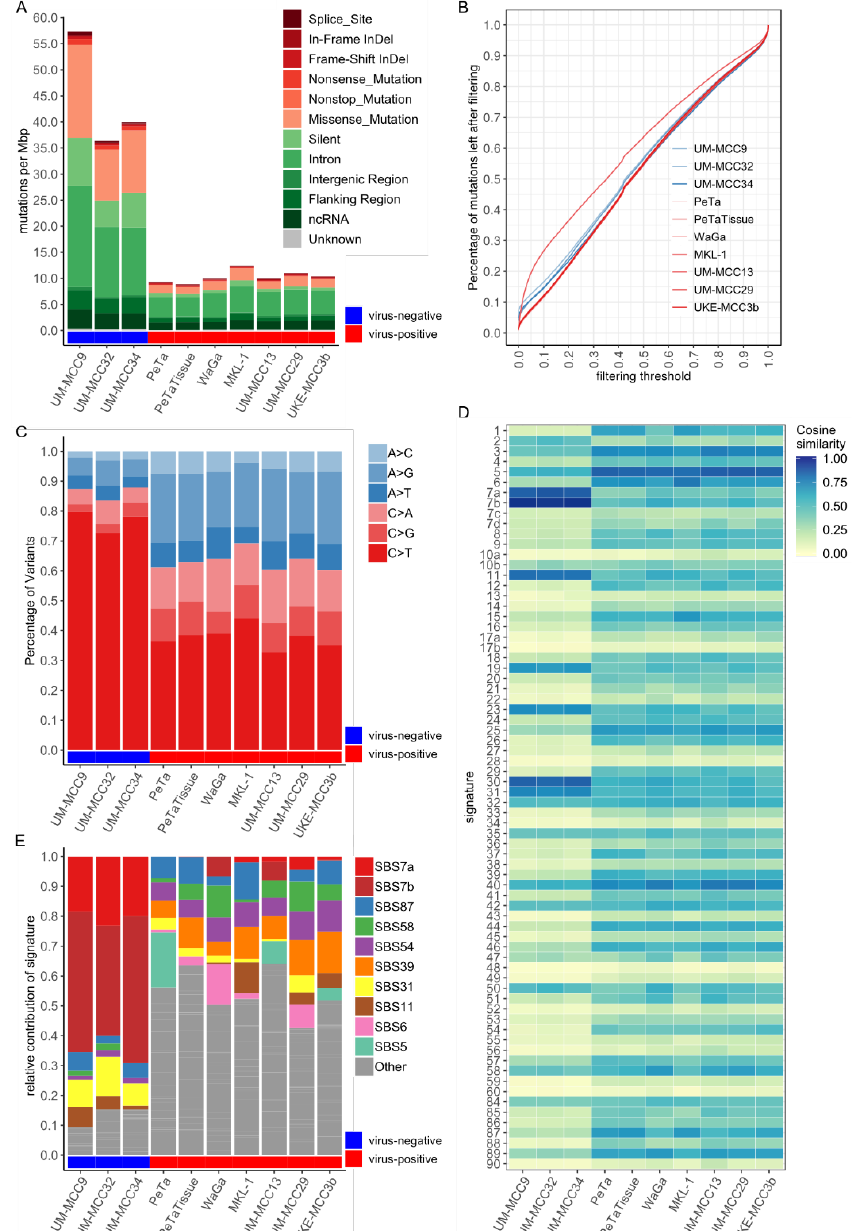
Figure 1. Virus-negative Merkel cell carcinoma (MCC) cell lines show high tumor mutational burden (TMB) and presence of UV-light-induced DNA damage, while virus-positive cell lines have low TMB and lack prominent signatures; ( A ) Mutational burden in mut/Mbp, color-coded by variant classification; ( B ) Filtering of polymorphisms in MCC cell lines showing the relative decrease in TMB (y-axis) with increasing variant allele frequency (VAF) threshold (x-axis) from gnomAD genome database; Figure S1A depicts the same plot with log-transformation of x-axis; ( C ) Contributions of base-pair transitions for single nucleotide variants (SNVs), normalized by total number of SNVs. Complementary transitions are merged in one category (e.g., G > A and C > T as C > T); ( D ) Cosine similarity between trinucleotide context frequencies (TCFs) of MCC cell lines and reference signatures reveals two distinct patterns for virus-positive and -negative cell lines; ( E ) Signature contribution of MCC cell lines after fitting to reference signatures. Signature contributions are normalized to total number of SNVs in the respective cell line. Signatures not reaching at least 10% contribution in at least one sample are summarized as “Other”. Abbreviations: mut/Mbp: Mutations per Megabasepair, SBS: Single Base Substitution.